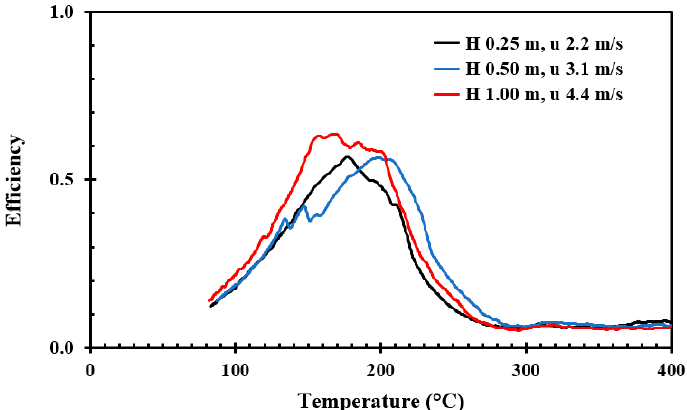
Figure 10. Cooling efficiency for pure water droplets at 30° disc inclination, droplet diameter 2.5 mm. Impingement heights and speeds are given in the figure label.